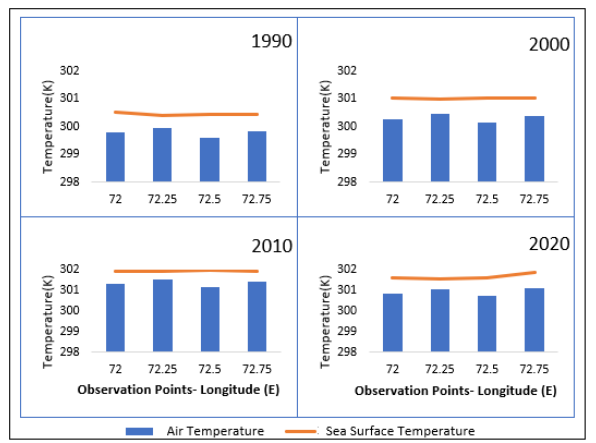
Figure 4 . Annual average AT vs Annual average SST (1990 –